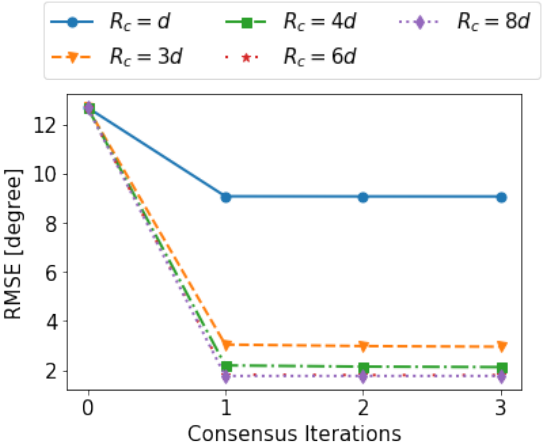
Figure 13. Heading RMSE as a function of the iterations and of the cooperation radius for the distributed approach.